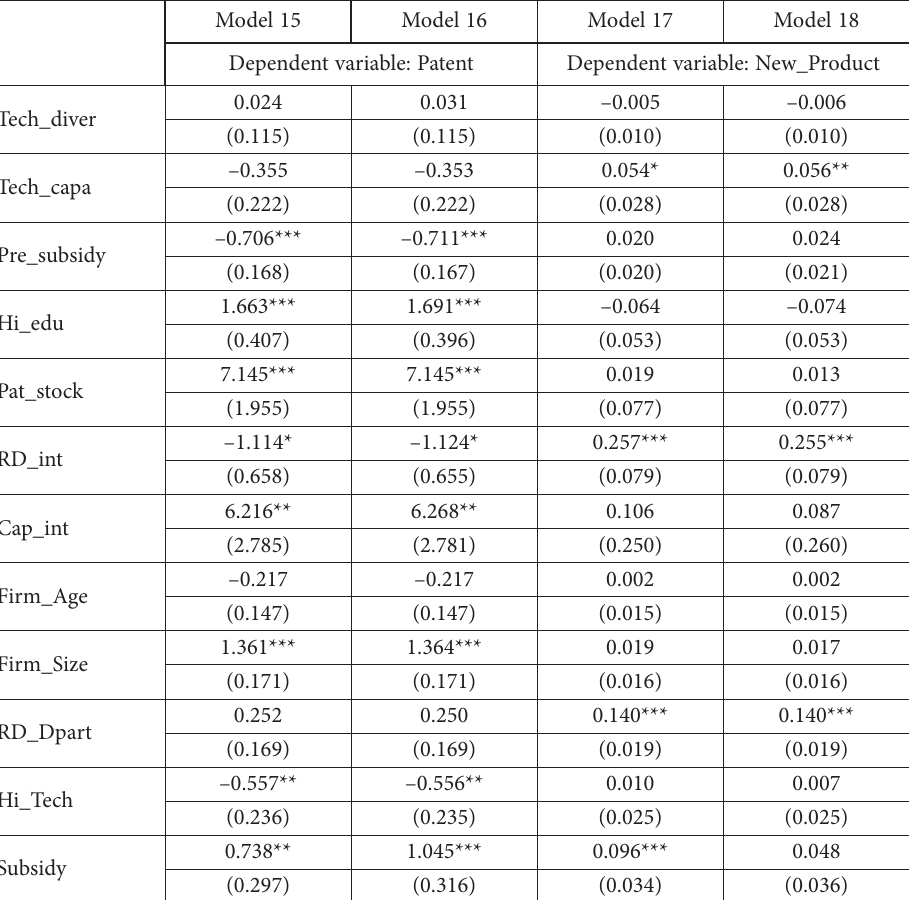
Table 5. The endogenous treatment effects